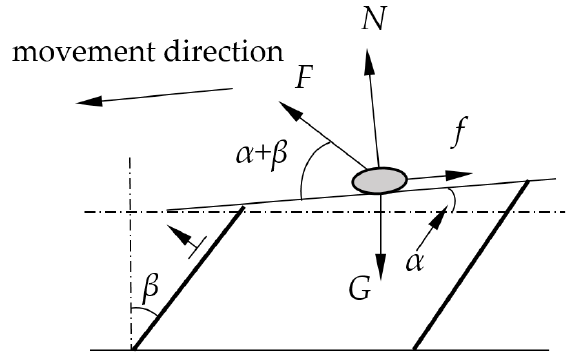
Figure 3. Sketch of forward slip force analysis.